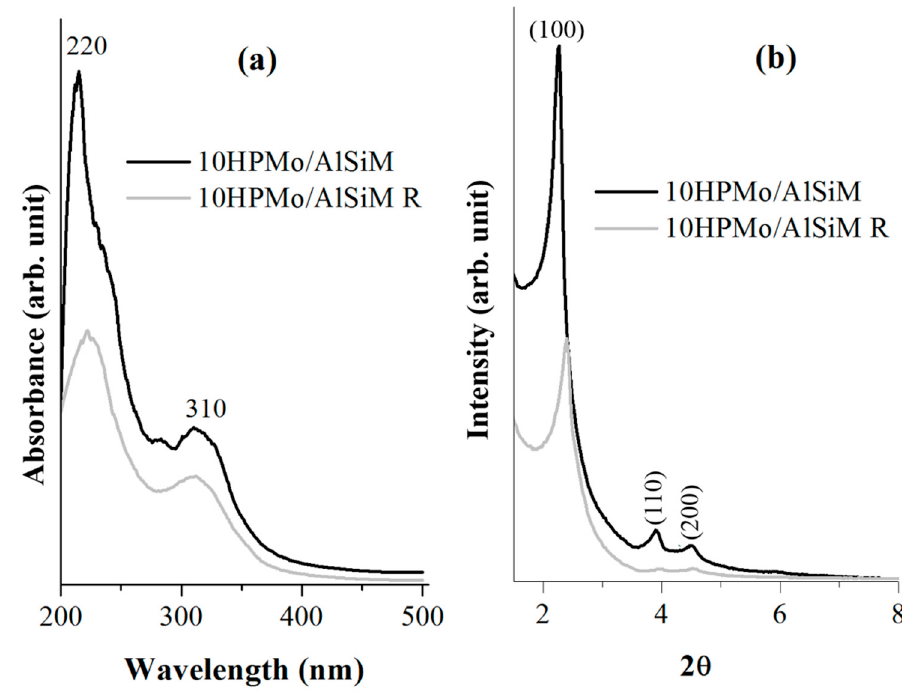
Figure 14. Data of fresh and reused catalysts: ( a ) Comparison of the DRS spectra; ( b ) XRD